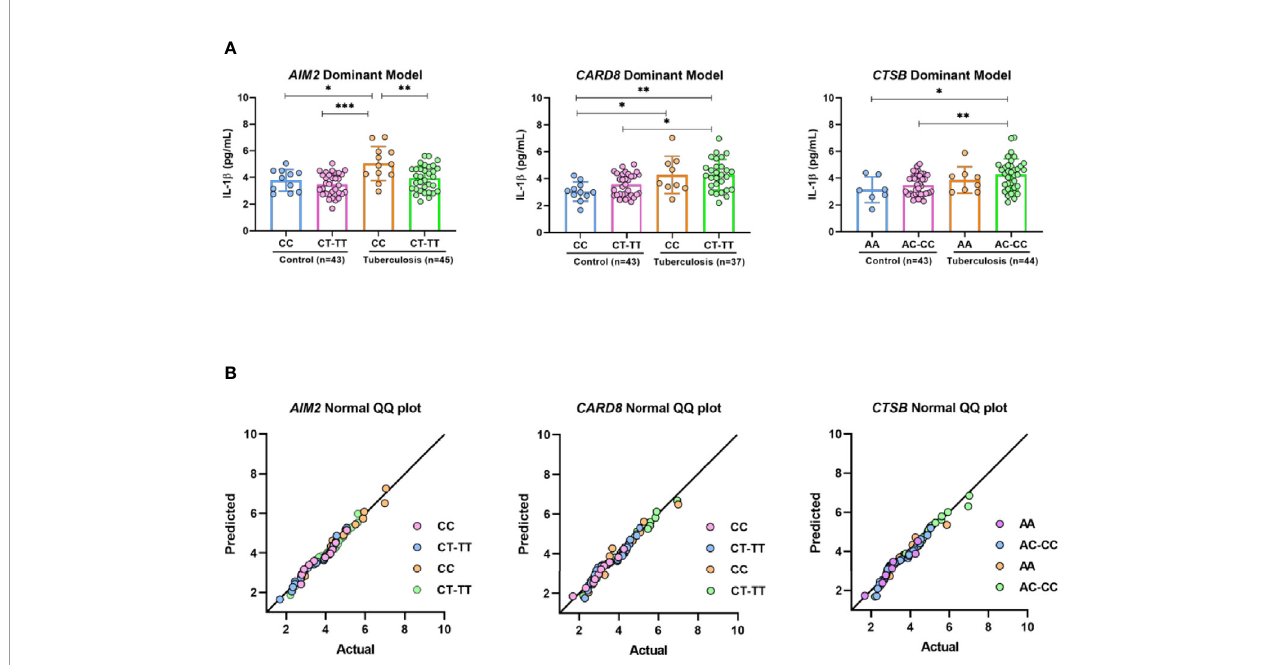
FIGURE 1 | IL-1 b pro fi le respective on genotypes of AIM2 , CARD8 and CTSB from pulmonary tuberculosis patients and control. (A) Serum concentrations of IL-1 b distributed in AIM2 , CARD8 and CTSB dominant model genotypes. (B) Graphic Normal QQ plot for three SNV studied. Groups were further compared with each other using ANOVA test with Tukey ’ s multiple comparisons test, * p < 0,05; ** p < 0,001; *** p < 0,0001.